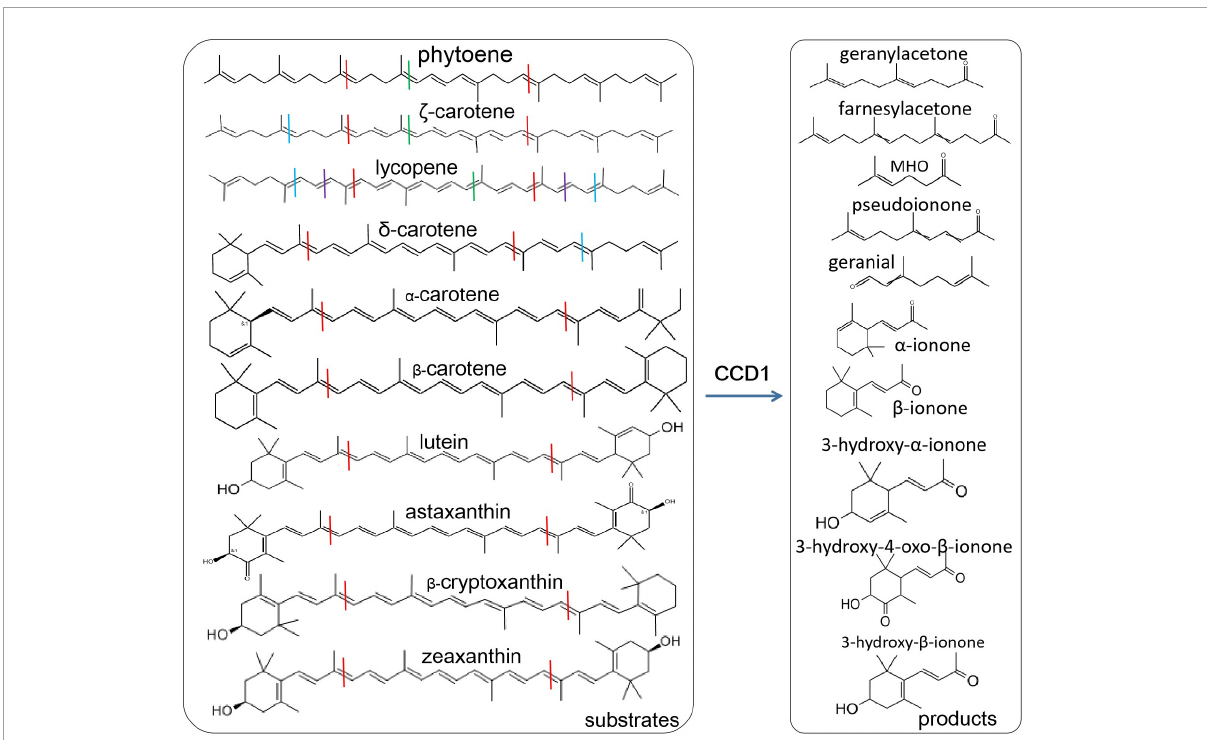
FIGURE1 Various carotenoid substrates and products by CCD1 cleavage. Lines with different colors indicate the cleavage sites, blue at 5, 6 and 5 (cid:48) , 6 (cid:48) ; red at 9, 10 and 9 (cid:48) , 10 (cid:48) ; dark red at 13, 14 and 13 (cid:48) , 14 (cid:48) ; purple at 7, 8, and 7 (cid:48) , 8 (cid:48)